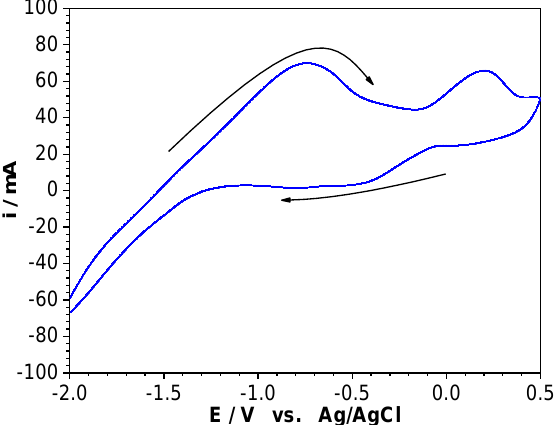
Figure 3. Cyclic voltammogram of AZ63 obtained from electrolytic solution between −2.0 V and +0.5 V at the scan rate of 100 mV·s −1 .